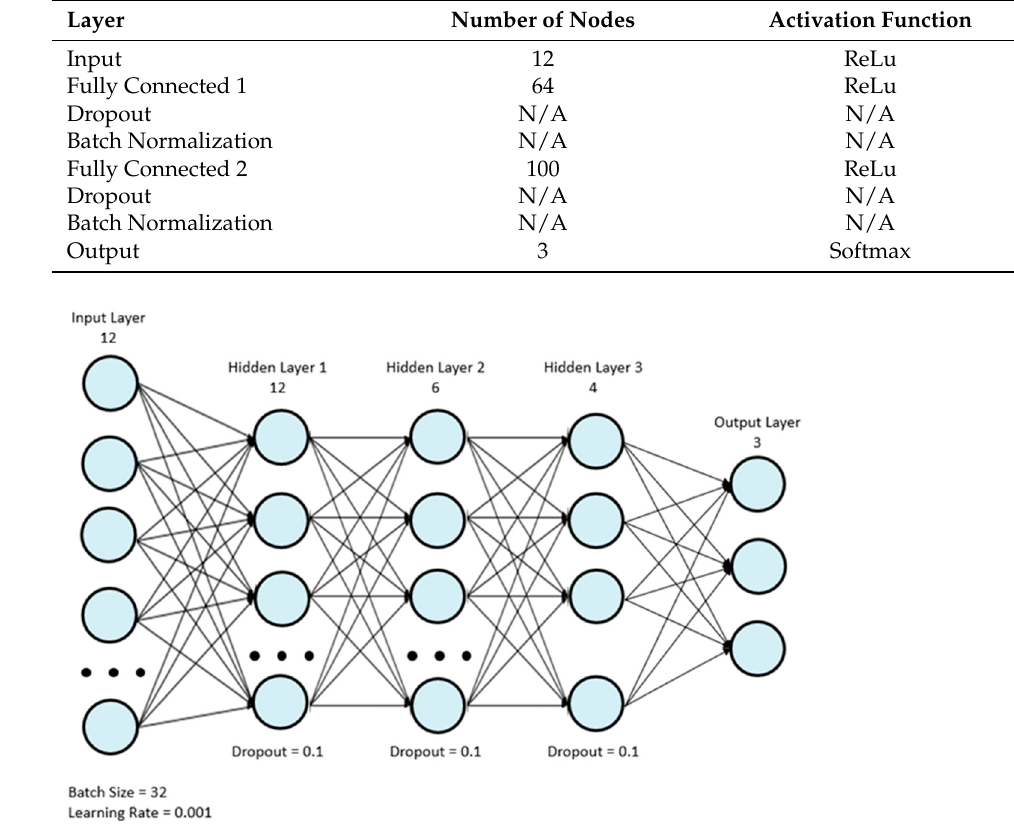
Figure 2. Final simplified MLP model.